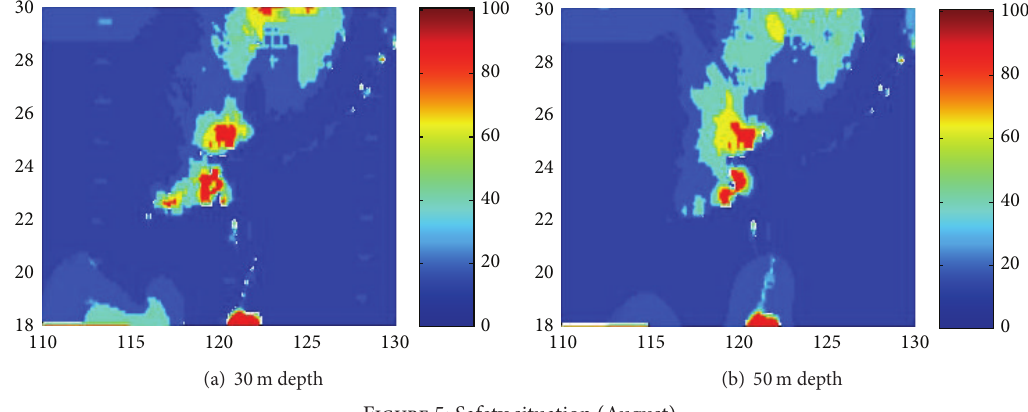
Figure 5: Safety situation (August).